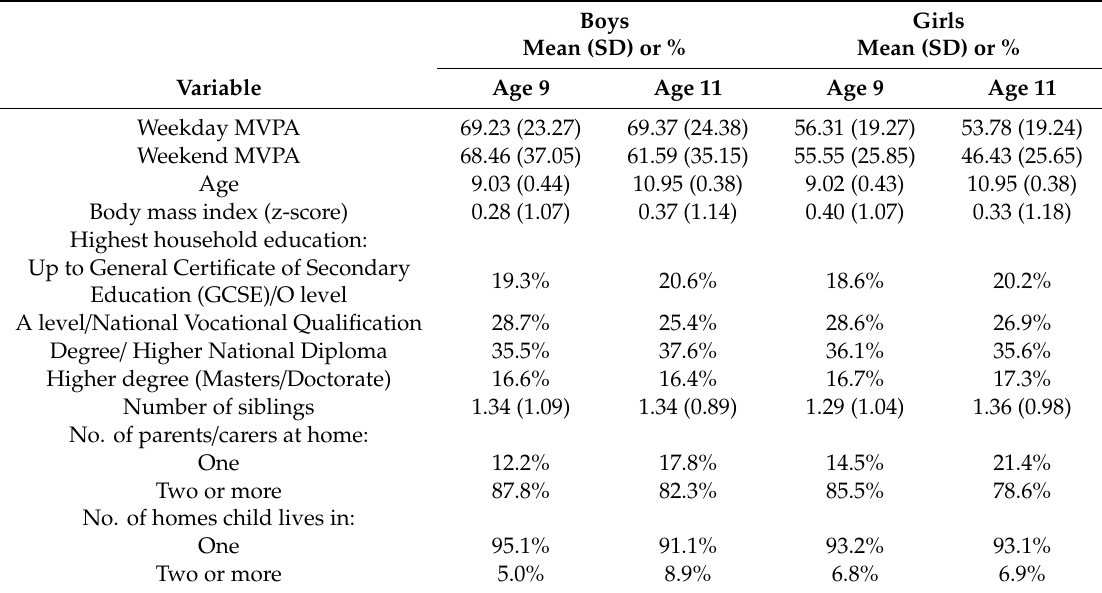
Table 2. Descriptive statistics of the